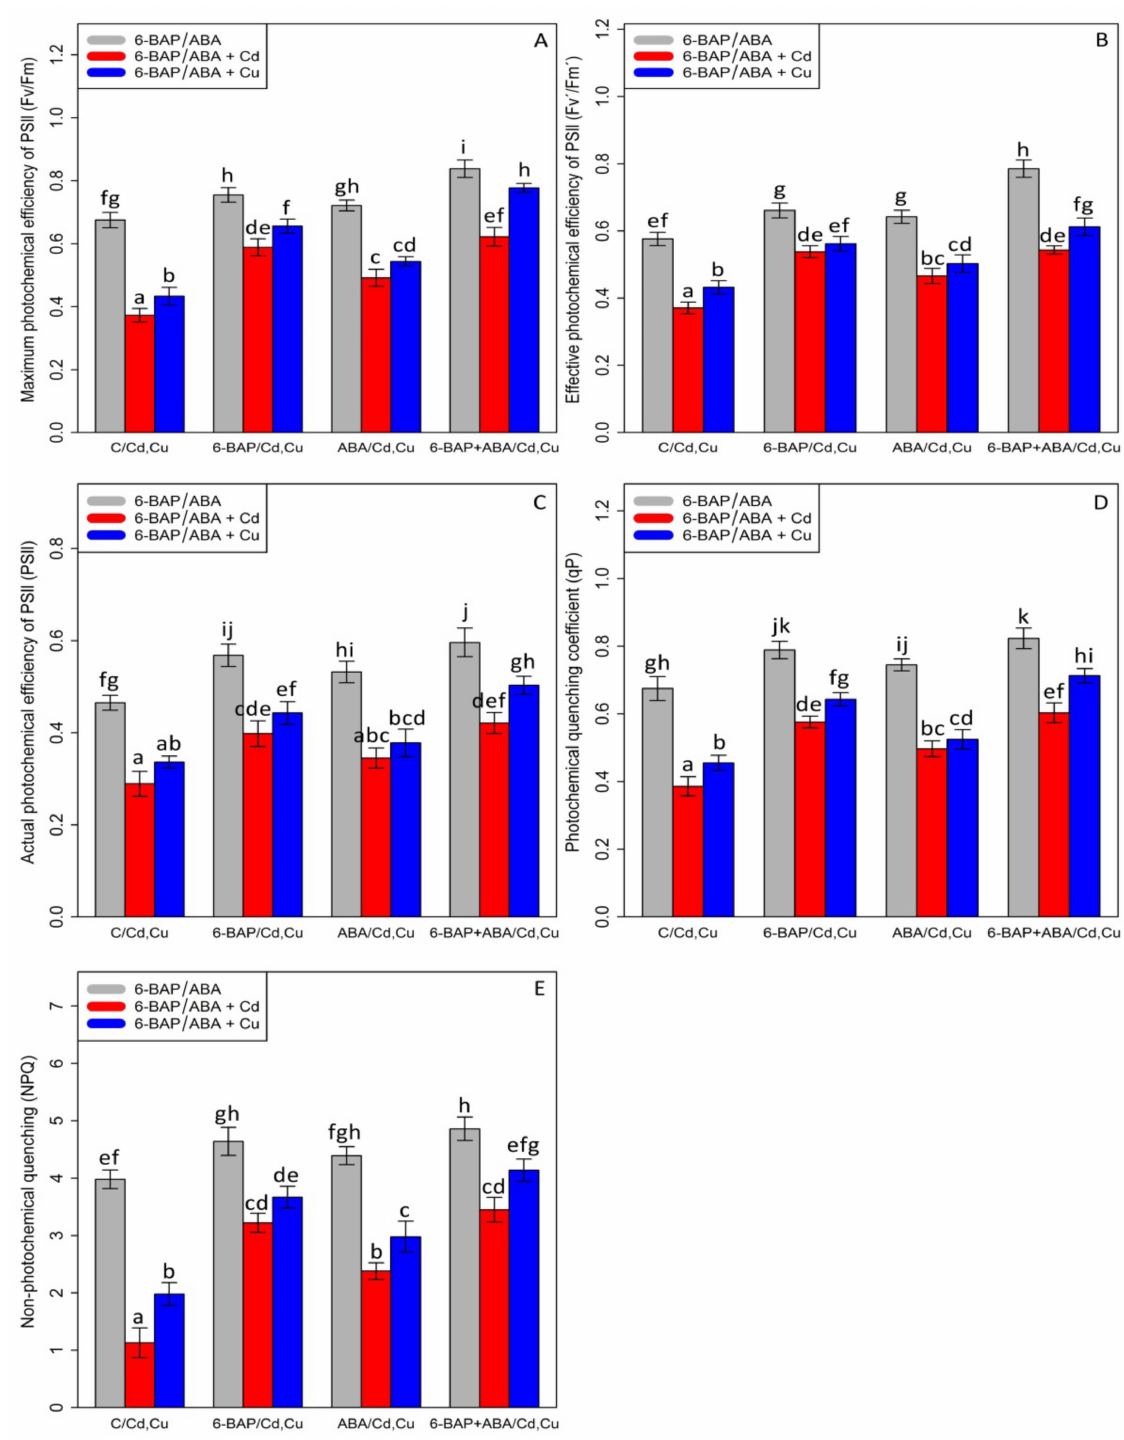
Figure 3. The impact of 6-benzylaminopurine and abscisic acid, alone and in combination, on the maximum photochemical efficiency of PSll (Fv/Fm) ( A ), effective photochemical efficiency of PSll (Fv (cid:48) /Fm (cid:48) ) ( B ), actual photochemical efficiency of PSll ( φ sPSll) ( C ), photochemical quenching coeffi- cient (qP) ( D ), and non-photochemical quenching (NPQ) ( E ) in the one-year-old Pleioblastus pygmaeus exposed to 100 µ M Cd and 100 µ M Cu. In this figure, a, b, c, etc. letters revealed significant differences between 6-BAP, ABA and 6-BAP + ABA in single and in the combined form with 100 µ M cadmium and 100 µ M copper based on Tukey’s test ( p <